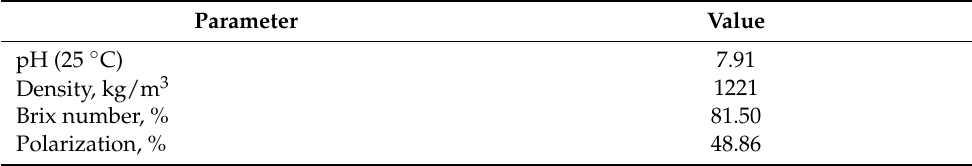
Table 1. Analysis of commercial molasses